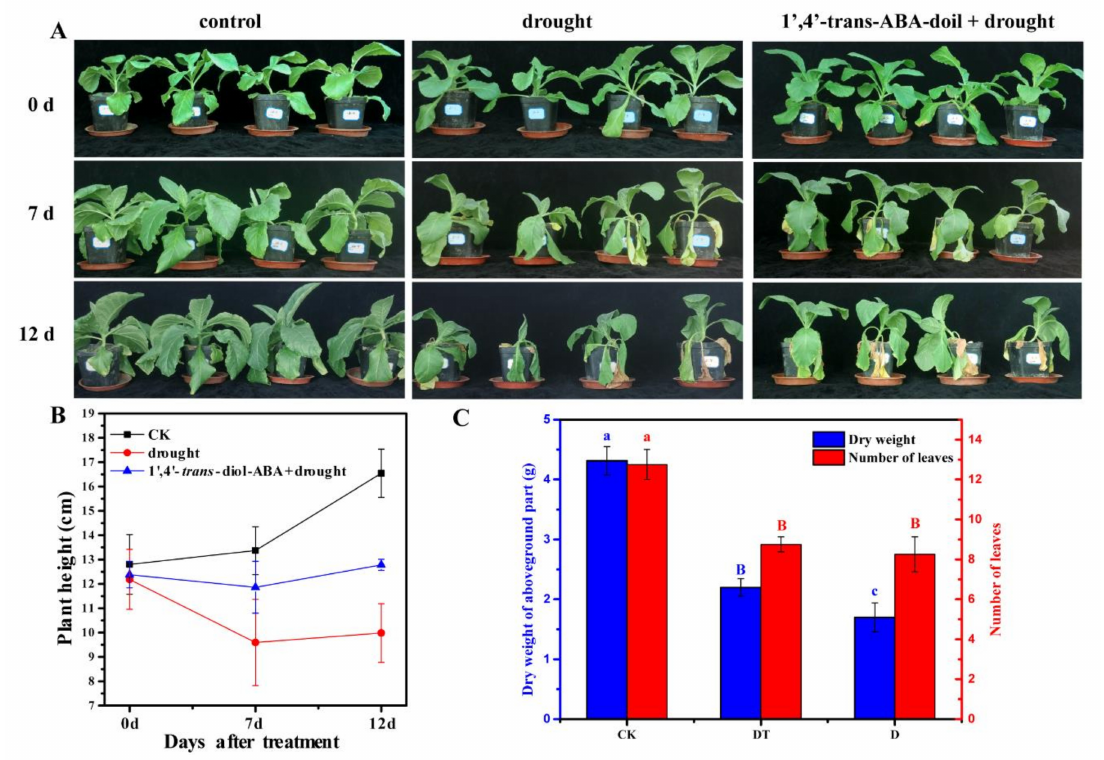
Figure 3. The effect of foliar spraying with 1 (cid:48) ,4 (cid:48) - trans -diol-ABA on the drought tolerance of tobacco seedlings. ( A ) Mor- phological changes of plants under drought stress. The pictures from left to right were the control with normal watering, drought treatment, and co-treatment of 1 (cid:48) ,4 (cid:48) - trans -diol-ABA spray and drought, observing the plant morphology at 0 d, 7 d and 12 d, respectively. ( B ) Plant heights at three time points exposed to different conditions. ( C ) The dry weights of aboveground part and number of leaves of the plants at 12 d after treatment. CK, control of keeping watering; DT, 1 (cid:48) ,4 (cid:48) - trans -diol-ABA spray and drought treated; D, drought treated only. Different letters indicate significant differences among different treatments (lowercase, p < 0.05; uppercase, p <